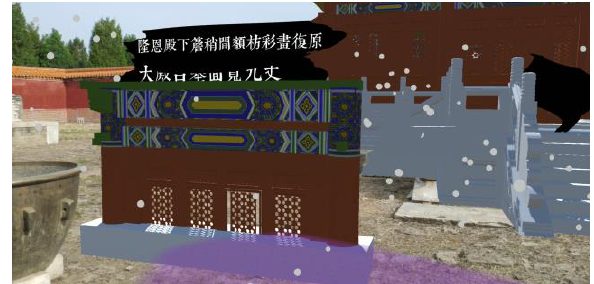
Figure 47. Components that are separated from the building